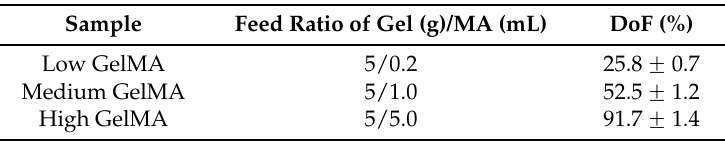
Figure 2. Photoluminescence spectra of 9,10-phenanthrenequinone after reaction with gelatin and GelMA macromers.